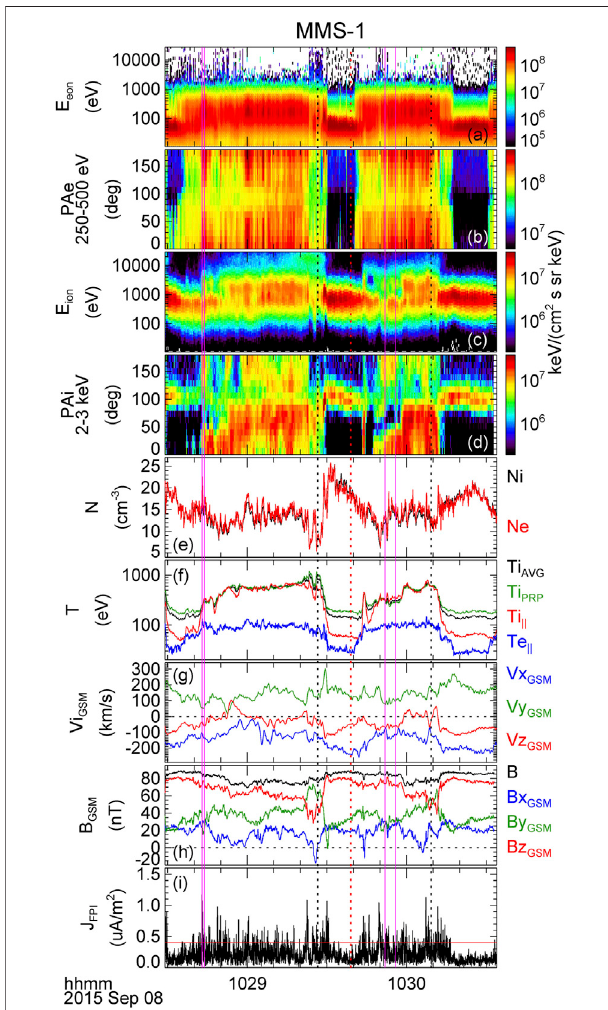
FIGURE 2 | MMS-1 observations in burst mode from 1028:29 UT to 1030:34 UT on 8 Sept 2015: (A) electron omni-directional energy-time spectrogram; (B) electron pitch-angle distribution in the 250 – 500 eV energy range; (C) ion omni-directional energy-time spectrogram; (D) ion pitch- angle distribution in the 2 – 3 keV energy range; (E) plasma number density for electrons(red)andions(black); (F) electronparalleltemperature(Te || ,blue),ion parallel temperature (Ti || , red), ion perpendicular temperature (Ti perp , green), and the ion average temperature Ti AVG (cid:1) (Ti || +2Ti perp )/3; (G) ion velocity in the GSM coordinate system; (H) magnetic fi eld GSM components and their magnitude (black); (I) magnitude of the current density GSM vector as measuredbytheFPIinstruments. Threedottedvertical lines markthetimesof 150-ms ion VDFs sampled at 1029:26.500 UT (black), 1029:39.000 UT (red), and 1030:09.299 UT (black). Four solid vertical lines in pink color mark two sustained periods of distinct counter-streaming ion beams in the ion VDFs at 1028:42.950 – 1028:43.849 UT and 1029:51.849 – 1029:55.900